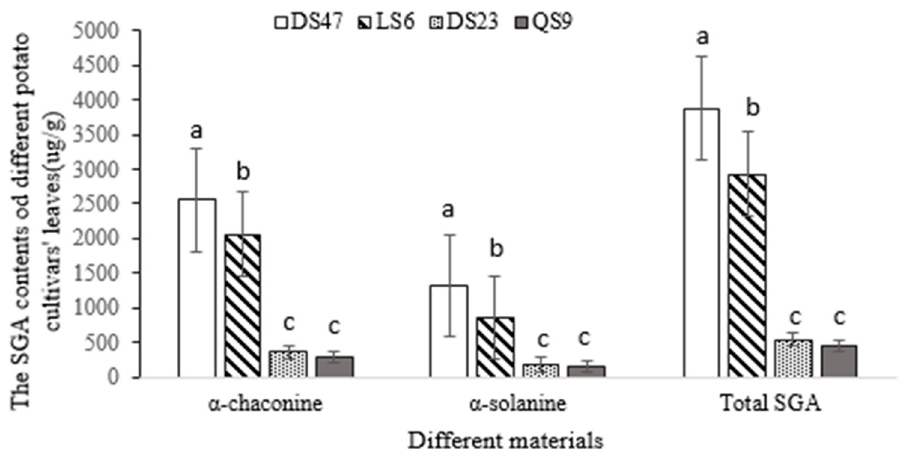
Figure 1. SGA concentrations in leaves of different potato cultivars. Different letters upon the column diagram are significantly different ( p < 0.05, Tukey’s test). Table 1. Growth and development of potato tuber moth (PTM) larval instars fed on different varieties of potato